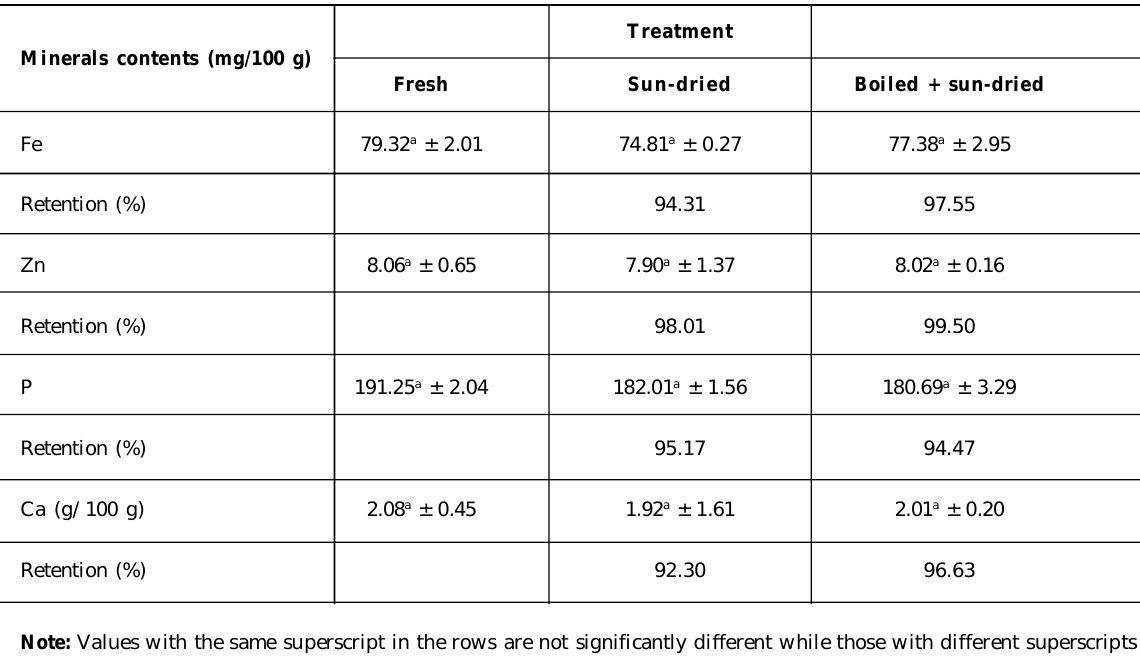
Minerals contents (mg/100 g)